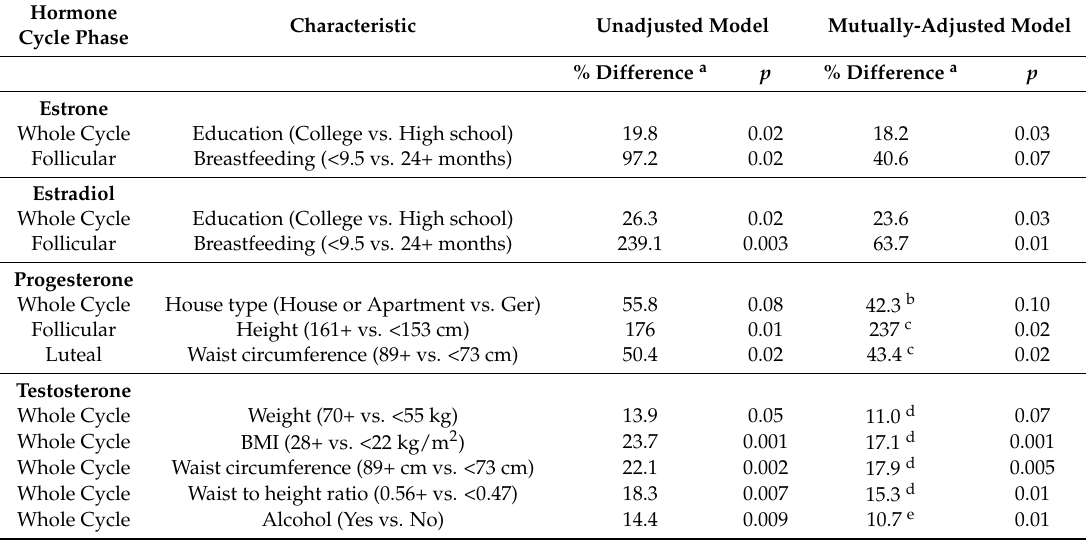
Table 3. Percent differences in hormones by characteristics of women before and after mutual